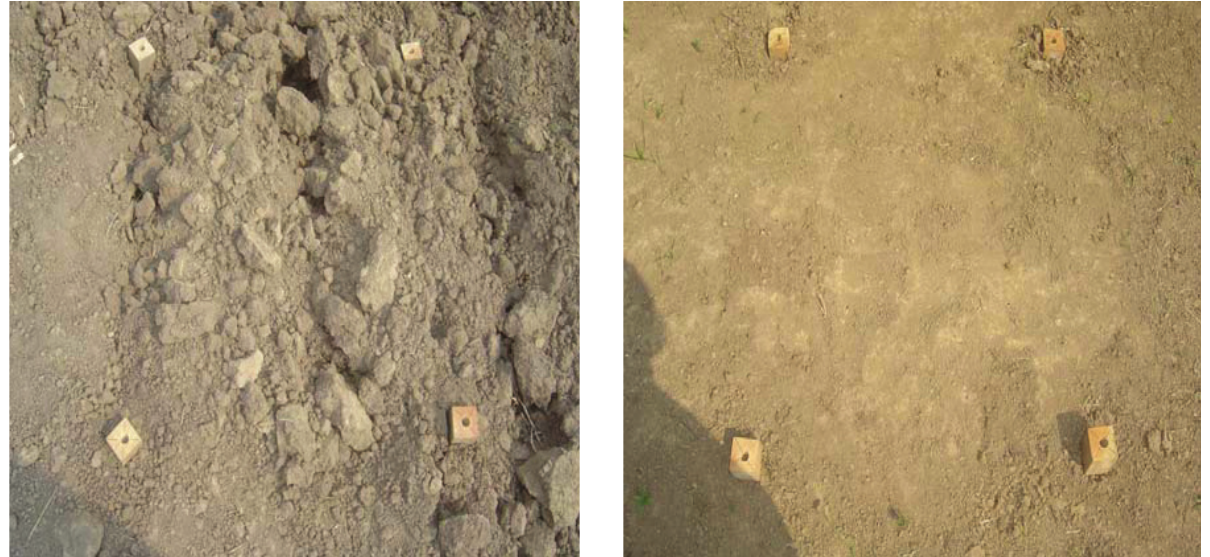
figura 2. superfície do solo referente aos tratamentos: uma aração e duas gradagens em solo não com- pactado (esquerda) e superfície quase lisa em solo compactado